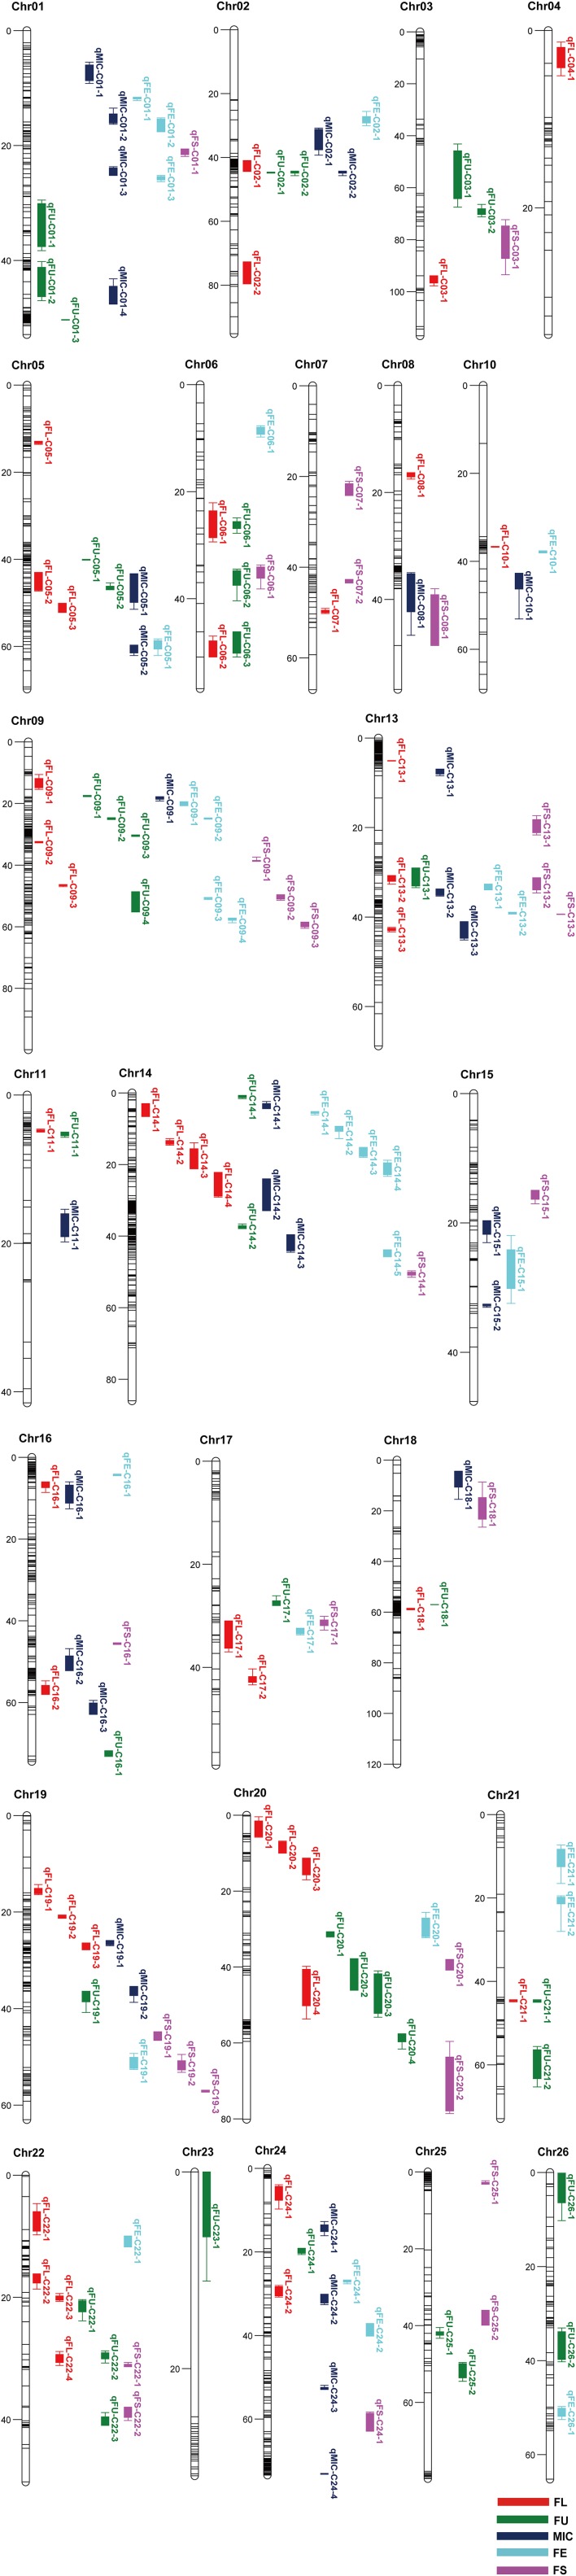
Chromosomal location of QTLs for fiber quality traits in IF2, HSBCF1, MARBCF1, IF2MPH, HSBCF1MPH, and MARBCF1MPH datasets across four environments. Map distances were given in centimorgans (cM). Solid bars with different colors represent different traits, and the legend is given at the end of figure. FL, fiber length; FU, fiber uniformity; MIC, micronaire; FE, fiber elongation; FS, fiber strength.